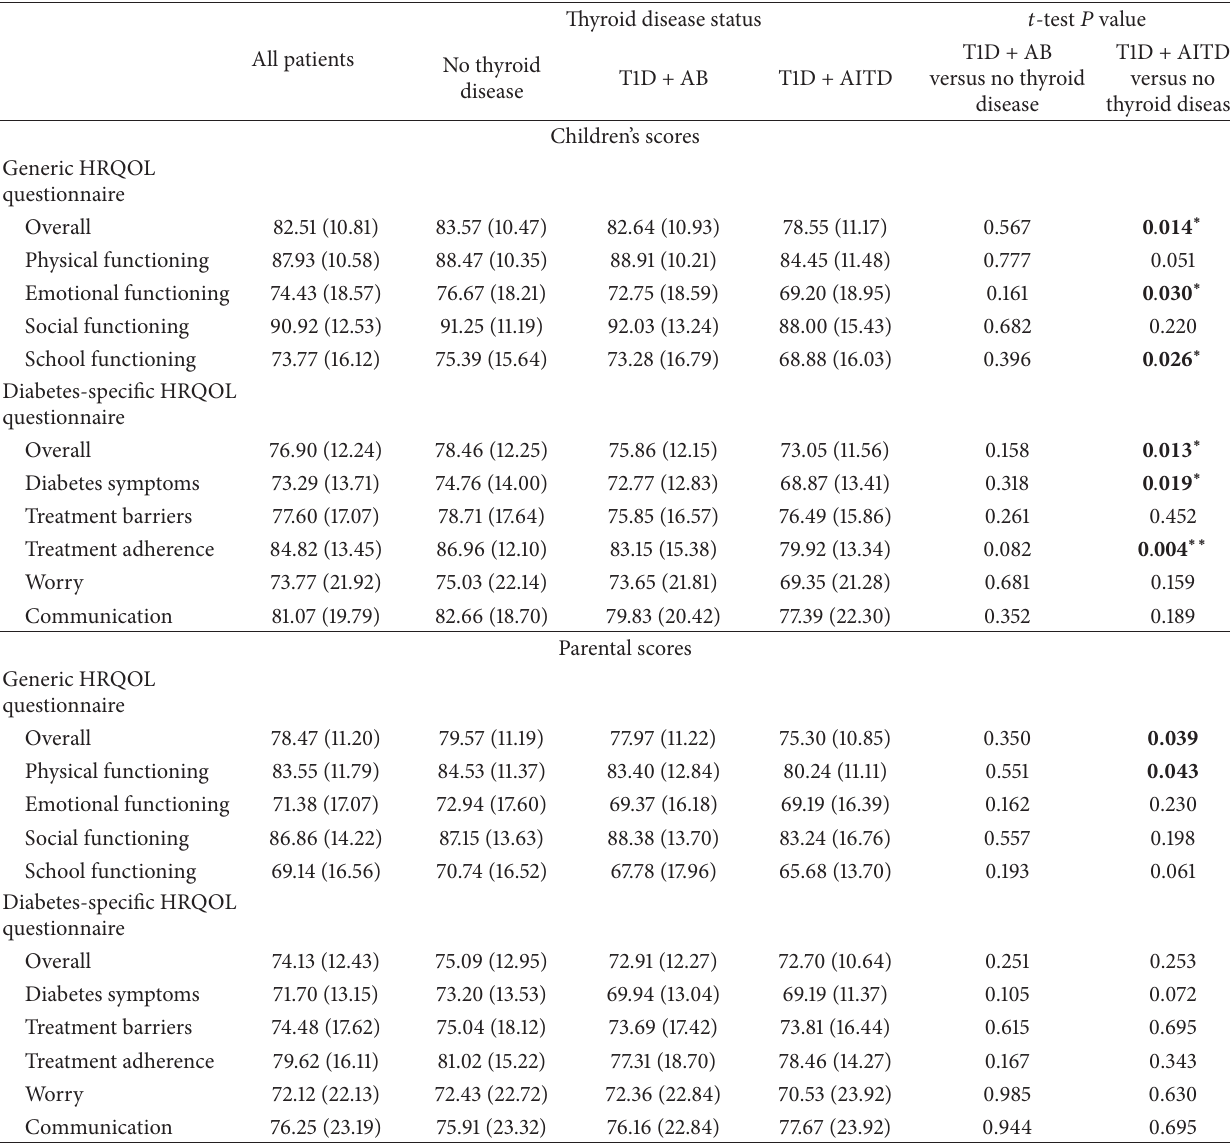
Table 2: Quality of life assessed using the HRQOL questionnaires, by thyroid